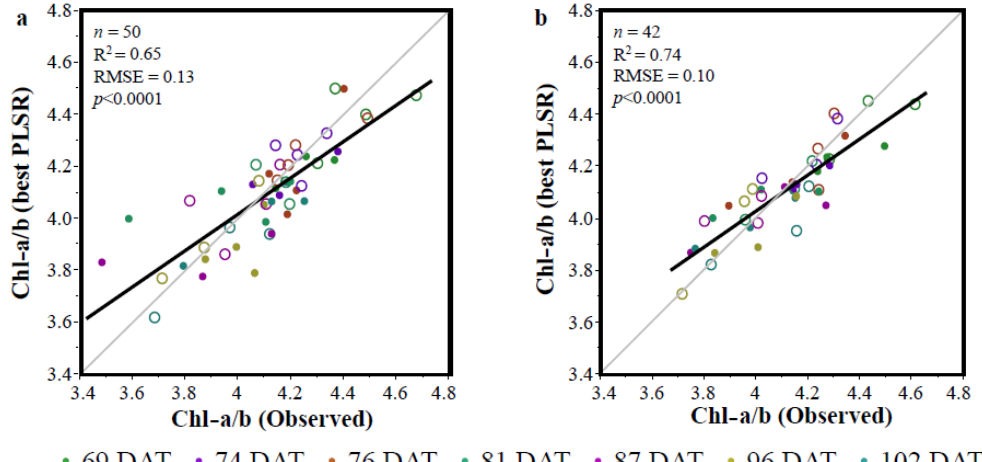
Figure 6. Quality of Chl-a/b spectral estimation. The Chl-a/b (observed) data were acquired by extraction of Chl-a and Chl-b. The Chl-a/b (best PLSR) data were calculated by applying the PLSR models estimating Chl-a and Chl-b (Table 2). The Val data set is presented in Table 2. Hollow and filled dots stand for water-limited (WL) and well-watered (WW), respectively ( a ). Averaged values per genotype, irrigation regime and DAT, as presented in Figure 5b,d,f ( b ). The black lines are the trend lines and the gray lines are the 1:1 lines. Hollow and filled dots stand for WL and WW, respectively.